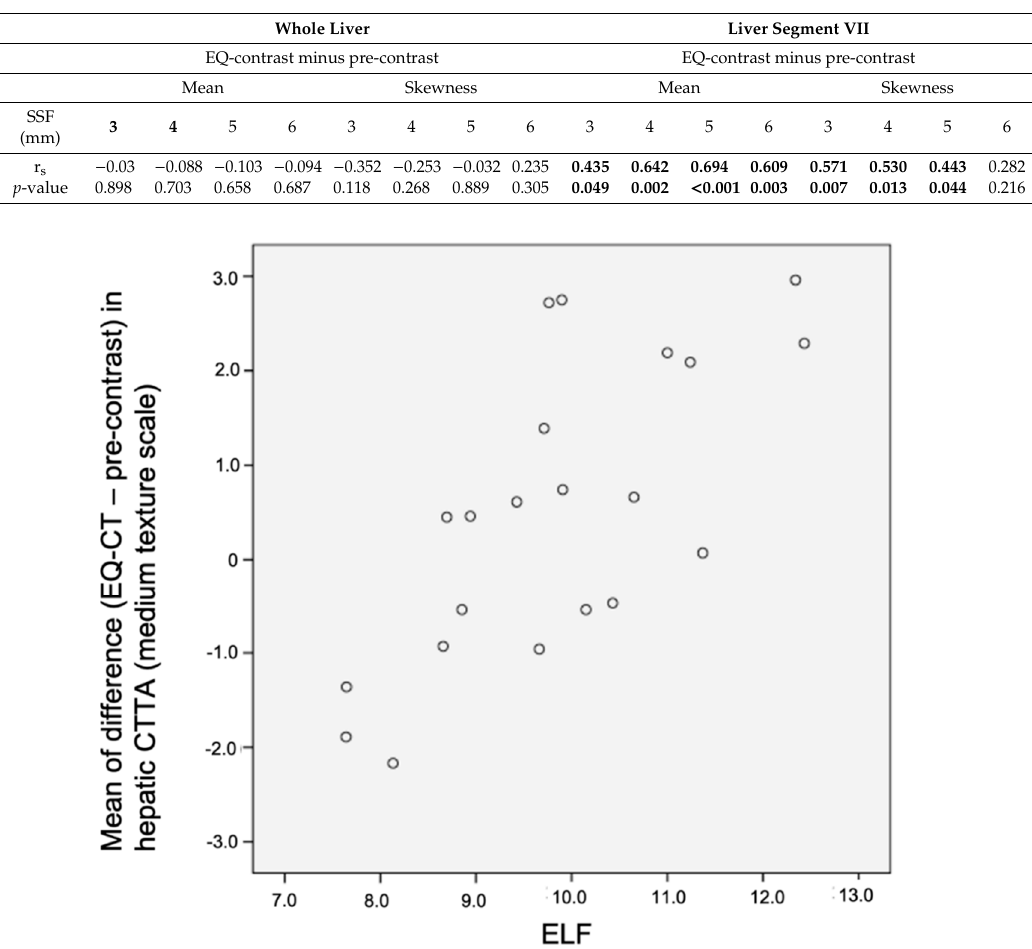
Figure 5. Scatter plot demonstrating correlation between mean of difference in hepatic CTTA versus ELF in segment VII liver texture analysis (r s = 0.69, p < 0.001). CTTA: CT texture analysis; ELF: enhanced liver fibrosis panel.